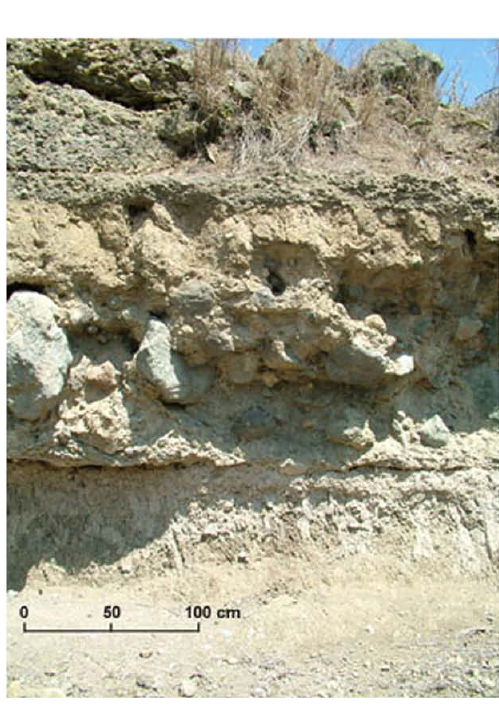
Fig. 4. Clayey level (paleosoil) between lahars and mantling